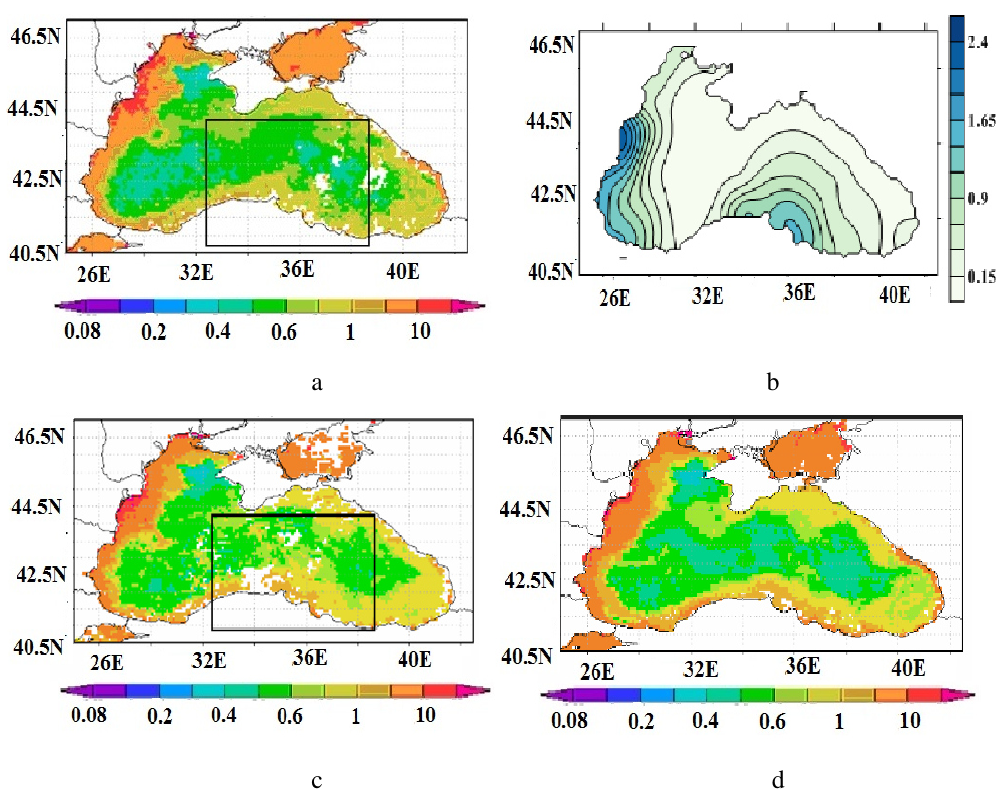
Figure 6. The atmospheric IFN input, mgNm − 3 , to the surface layer of seawater in 31 May 2004 (b) and averaged chlorophyll a concen- trations, mgm − 3 , in 24–31 May 2004 (a) , in 1–8 June 2004 (c) , 17–24 June (d) . Square figures represent the area of the maximum effect of the atmospheric IFN